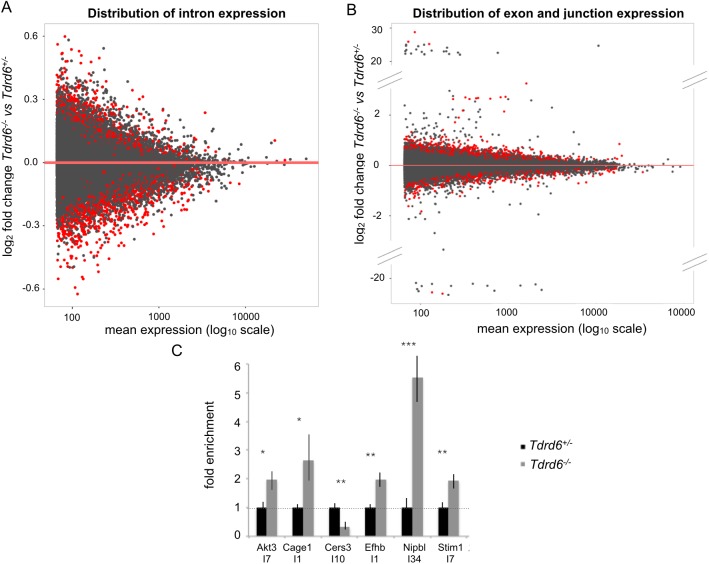
The differential expression of introns, exons and splice junctions in TDRD6-deficient primary spermatocytes.(A) Distribution of differential usage of introns in Tdrd6-/- vs. Tdrd6+/- primary spermatocytes. Each dot represents one unique intron. The log2 fold change in Tdrd6-/- versus Tdrd6+/- is represented on the y-axis while log10 mean expression for individual introns is displayed on the x-axis. Introns that differ significantly (p-value < 0.1) between the two conditions are represented with red dots. (B) Distribution of differentially used exons and exon-exon junctions in Tdrd6-/- vs. Tdrd6+/- primary spermatocytes. Each dot represents an event; i.e. one exon or one splice junction. The log2 fold change in Tdrd6-/- versus Tdrd6+/- is represented on the y-axis while log10 mean expression for individual events is displayed on the x-axis. Events that differ significantly (p-value < 0.1) between the two conditions are represented with red dots. (C) RT-qPCR of total RNA of Tdrd6+/- and Tdrd6-/- diplotene cells using specific primers for I7 of Akt3, I1 of Cage1, I10 of Cers3, I1 of Efhb, I34 of Nipbl and I7 of Stim1. RNA samples were different than those used for deep sequencing (n = 3 technical replicates); * significant at p value<0.1, ** significant at p value<0.05, *** significant at p value<0.01.